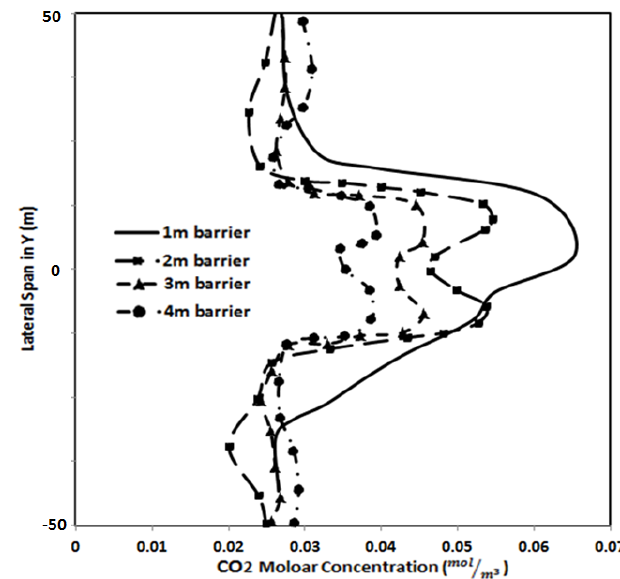
Figure 13. CO 2 concentration profile at downwind X = 10 m.